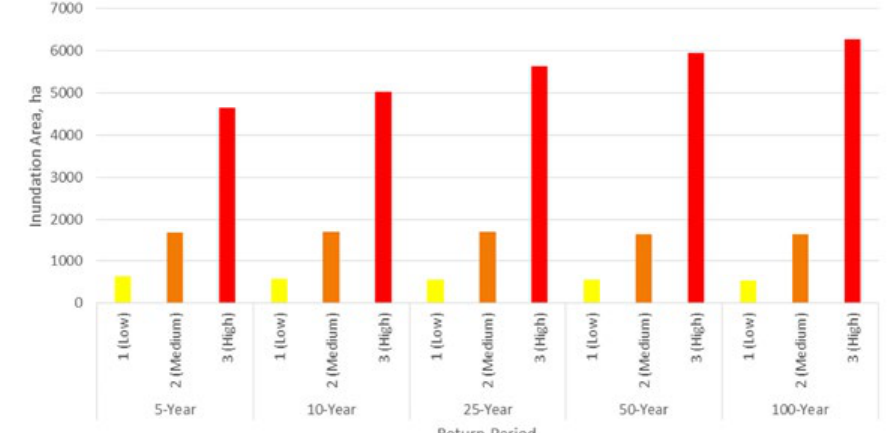
Fig. 9: Flood inundation area of Kalilangan, Bukidnon in varying return periods